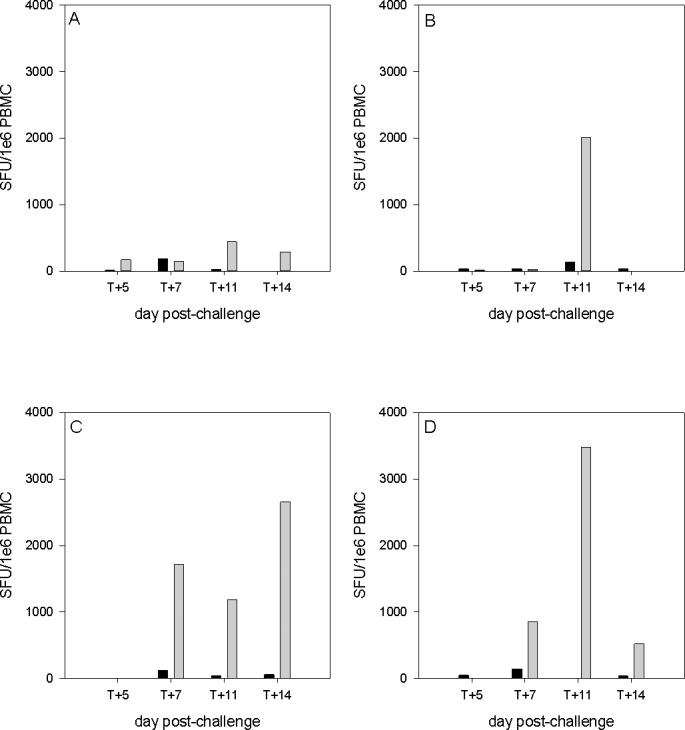
Interferon-γ secreting cells following stimulation of PBMCs with H1N1pdm virus.Each panel represents one of the challenge groups. For each NHP, the frequency of virus-specific cells measured by ELISPOT at day of cull (pale grey) and 4–6 weeks prior to challenge (black) are compared. Groups as in Table 1.